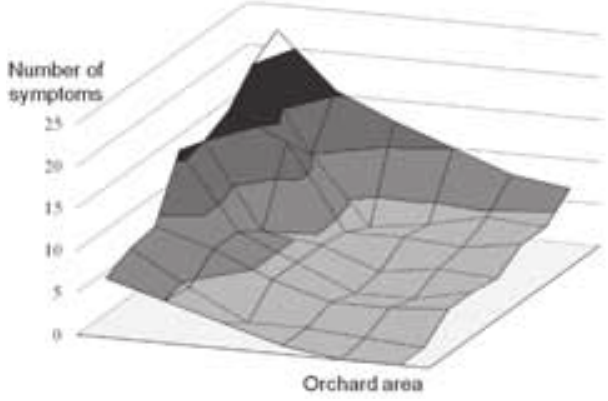
Figure 2: Number of scab symptoms on 20 May on cv. ’Mutsu’ in an organic apple orchard (Eperjeske, 2012 and 2013, combined